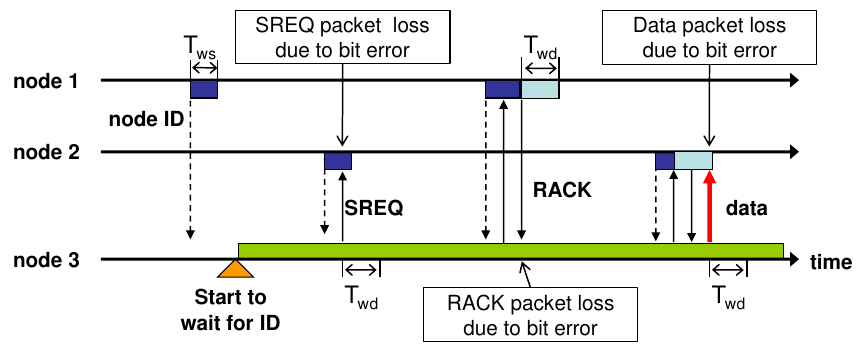
and T timers in ws wd